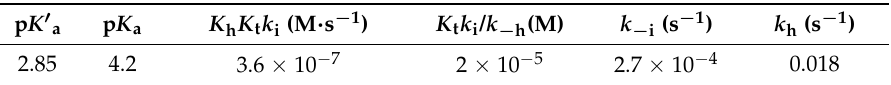
Figure 2. ( a ) Spectral variations after a direct pH jump 1–5.5; k obs = 1 × 10 − 3 s − 1 ; ( b ) Representation of the pH dependent rate constants of the kinetic process to reach the equilibrium after a direct pH jump. Fitting was achieved by means of Equation (12) for the parameters reported in Table 1. Table 1. Parameters obtained from Figure 1 to Figure 2.